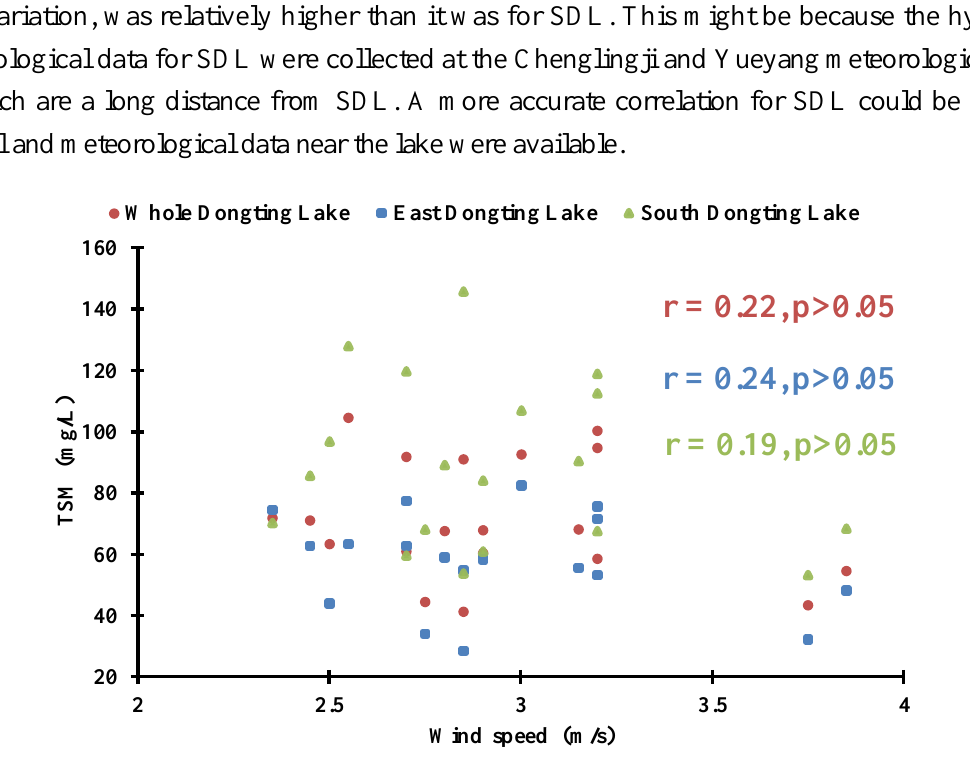
Figure 10. Relationship between mean TSM and wind speed, 1978–2013. No significant correlations were found for WDL, EDL or